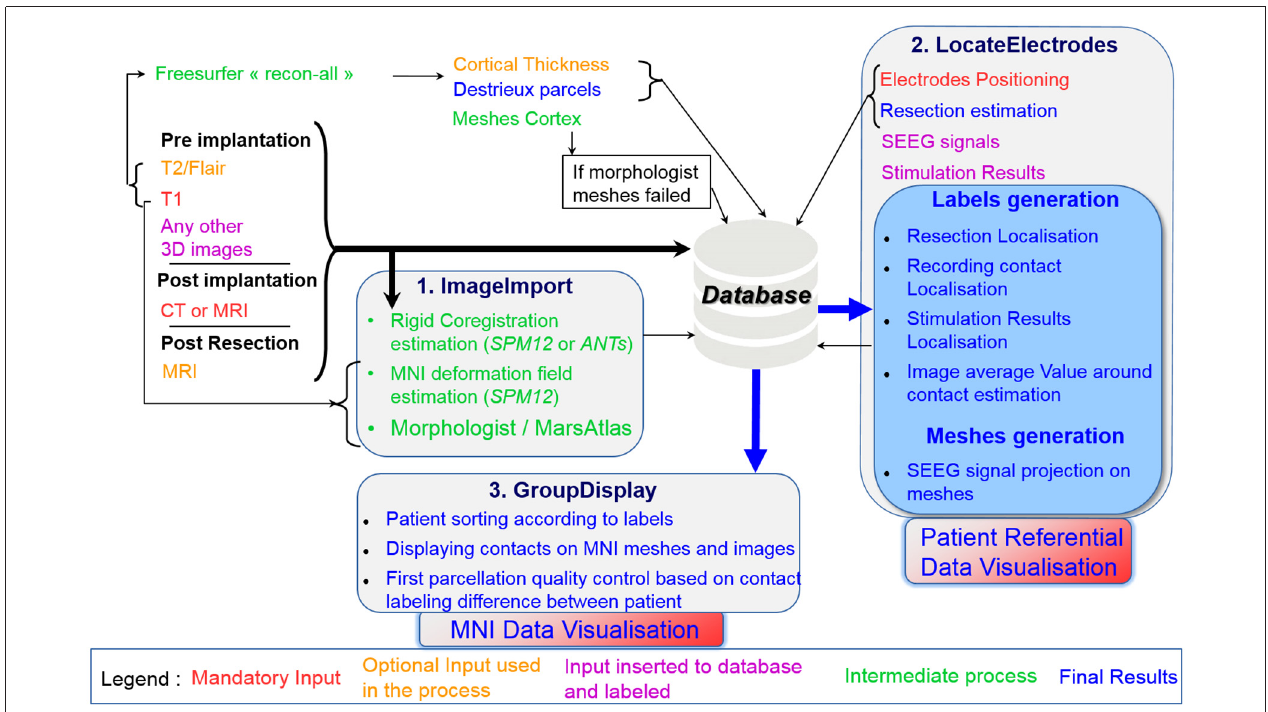
FIGURE 1 | Summary of the data importation and workflow of IntrAnat Electrodes with the three graphical user interface (GUI) interfaces.